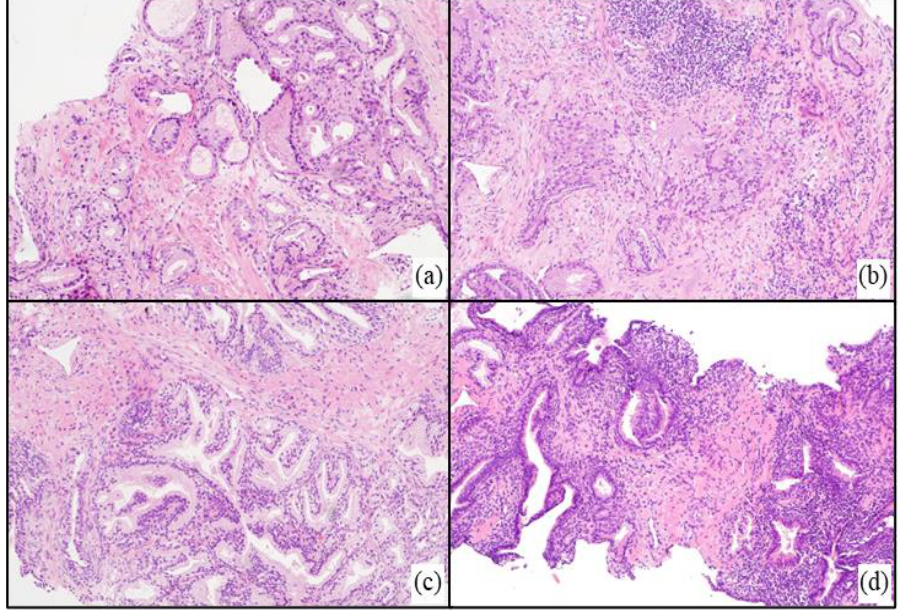
Figure 1. Representative histological slides displaying the different tissue conditions for the four subgroups: ( a ) noI-PCa; ( b ) I-PCa; ( c ) noI-BPH; ( d ) I-BPH.